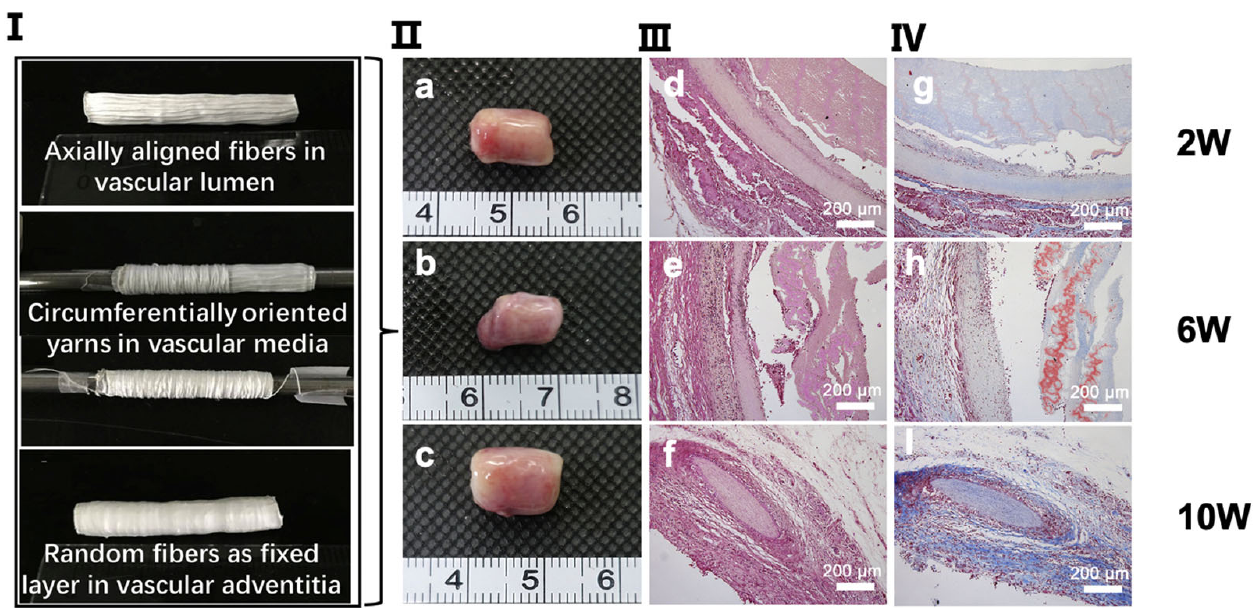
aligned scaffolds appear more like ECs in the human body, with a higher ability to resist blood flows, attach to matrices, and form a continuous endothelial layer.